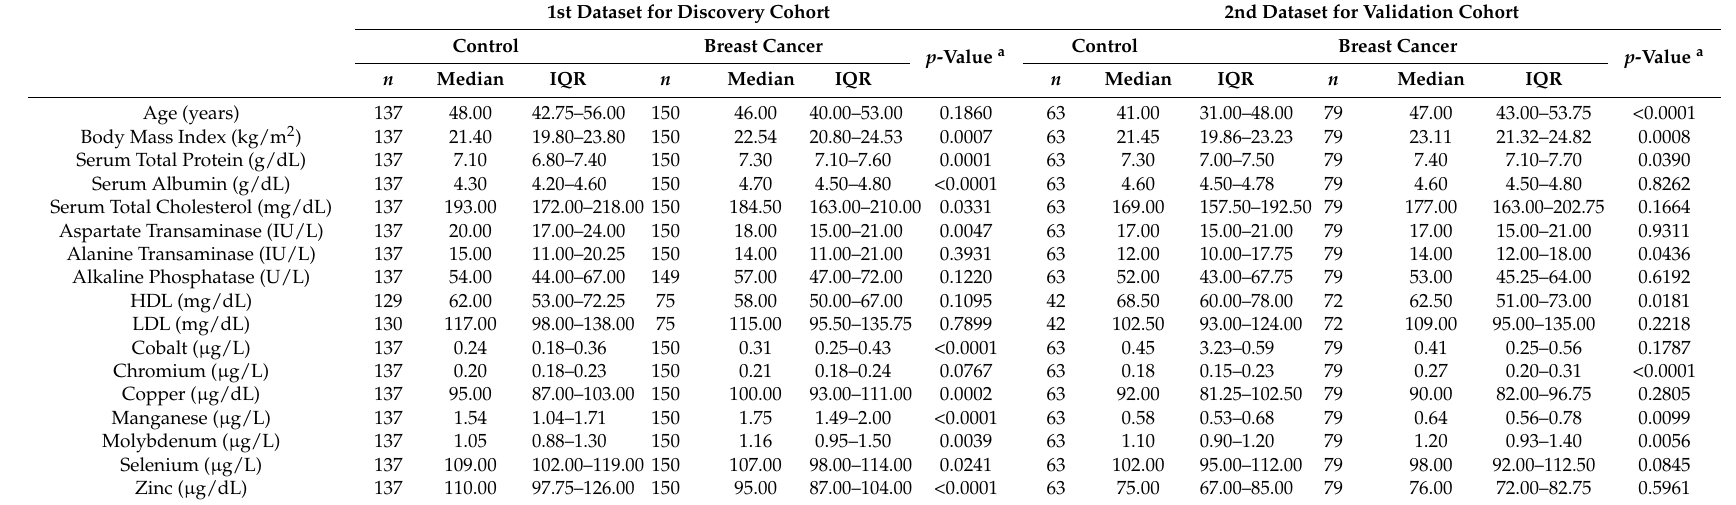
Table 1. Characteristics and levels of seven trace elements in study subjects and risk of breast